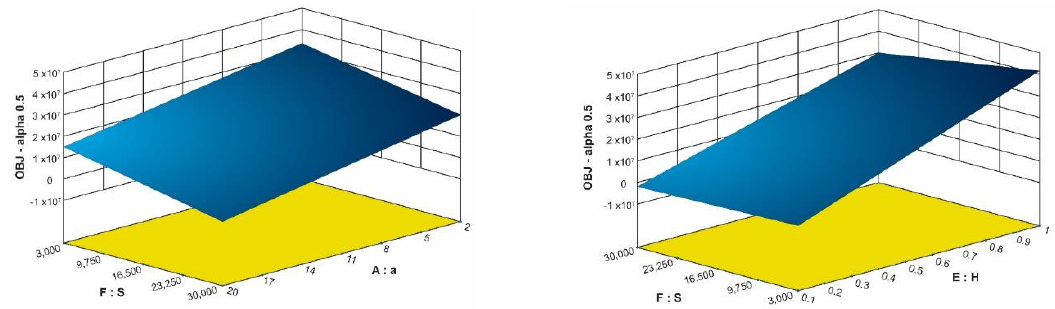
Figure 4. Objective function diagram as a function of (O and P) parameters with lower demand limit and α = 0.1.